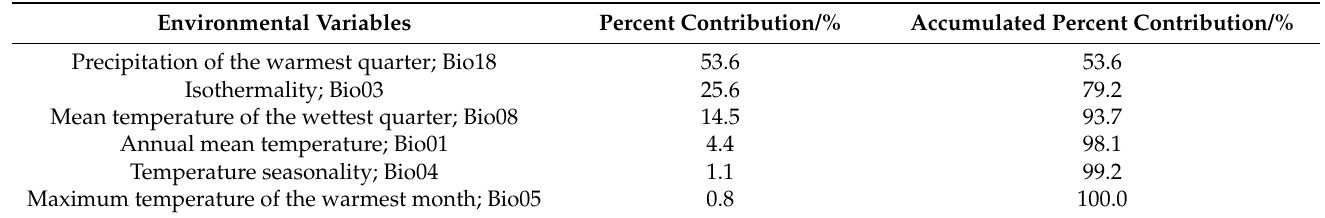
Table 1. The accumulated contribution of selected environmental variables to the potential distribu- tion of M. raddei defined by MaxEnt.